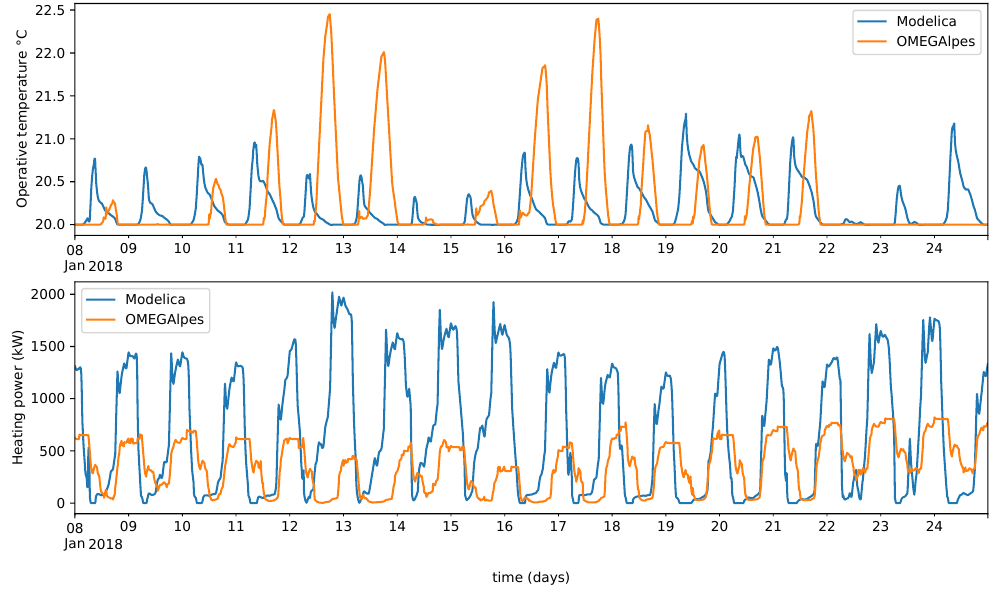
Figure 16. Comparison between Modelica and OMEGAlpes—Constant temperature set point